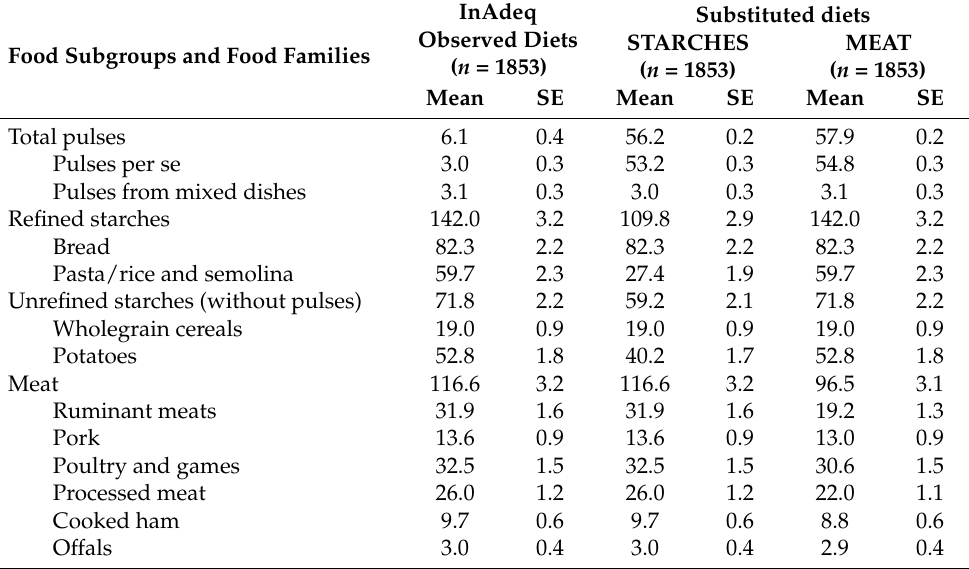
Table 4. Mean quantities of specific food subgroups and food families in observed diets not meet- ing the recommended guideline for pulses (InAdeq), and in substituted diets obtained with the STARCHES scenario (iso-portion replacement of starches with pulses until the French recommended guideline for pulses is reached, i.e., 57 g/day) and the MEAT scenario (iso-portion replacement of meat with pulses until the guideline for pulses is